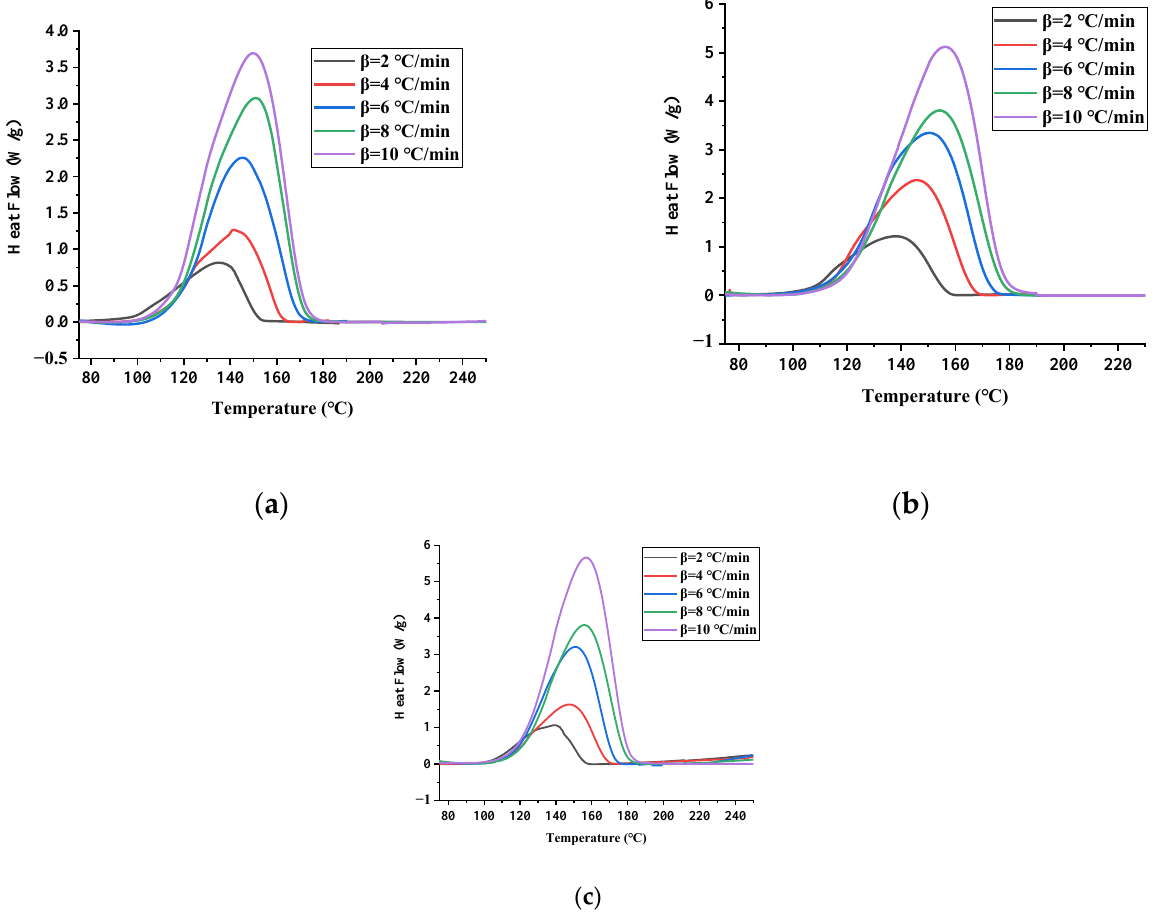
Figure 3. Heat flow curves of pure TBPTMH ( a ) and mixtures with H 2 SO 4 and NaOH ( b , c ) at different heating rates by DSC tests.